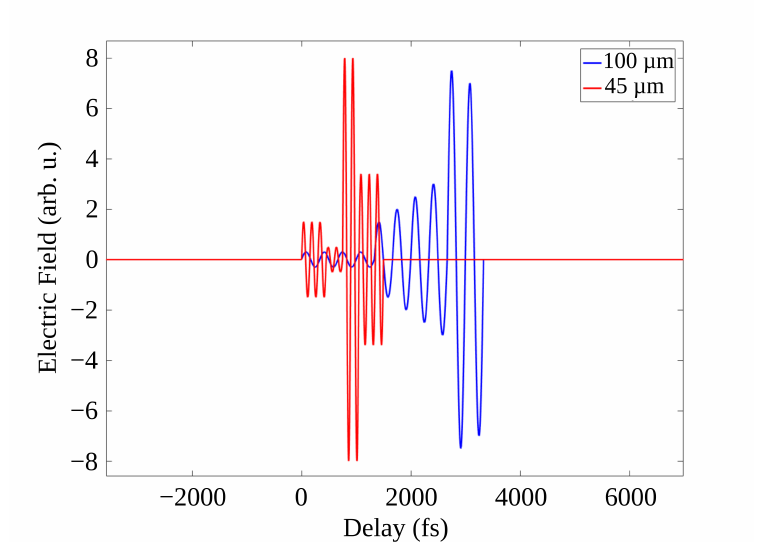
Figure 6. Reconstructed electric field of the THz radiation obtained by fitting the results of Figure 5 by Equation (1) for fundamental wavelengths of 45µm (red) and 100µm (blue). The fit neglects the higher harmonics for simplicity. The intensity is not uniformly spread among cycles and the most intense cycles are not located at the same position within the pulse for the two different